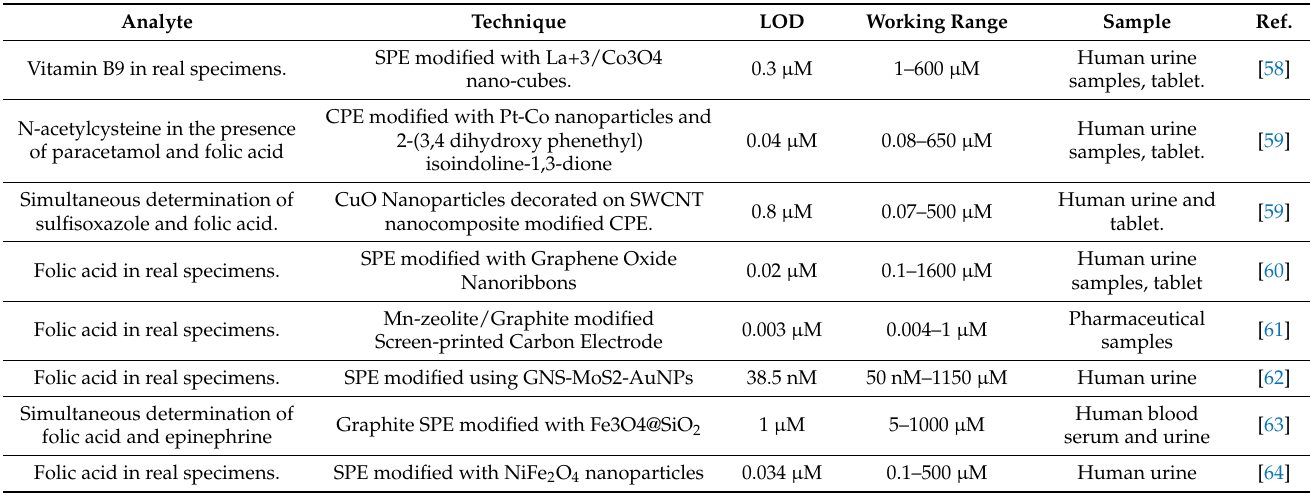
Table 6. Summary of biosensors based on SEPs for the determination of FA in various samples.